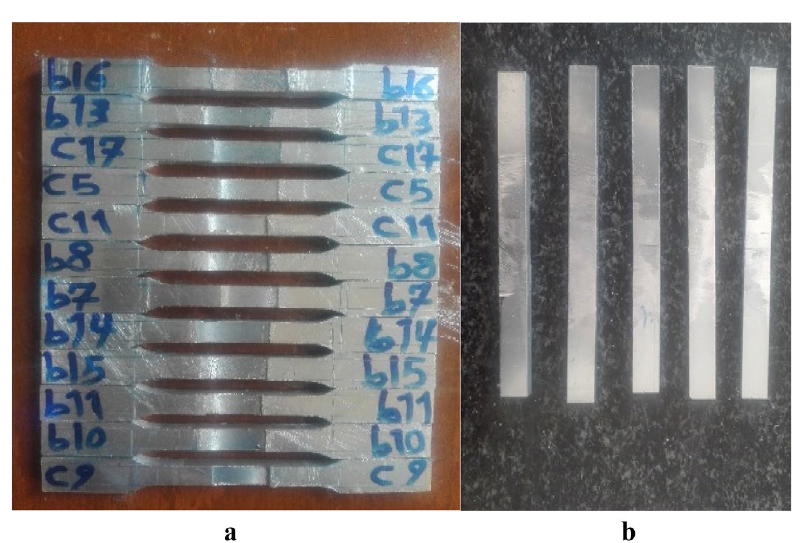
Figure 7. Prepared samples for ( a ) tensile test and ( b ) impact